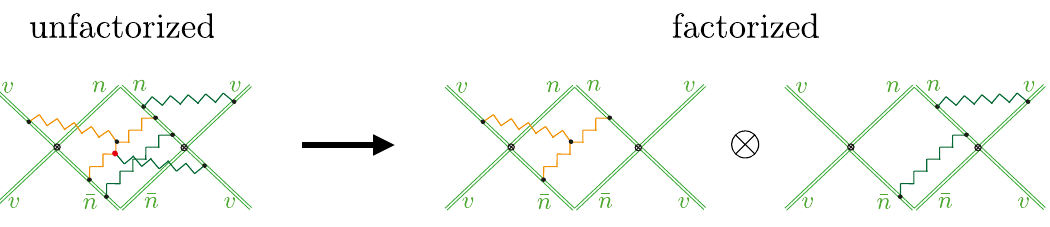
(dark green) from W